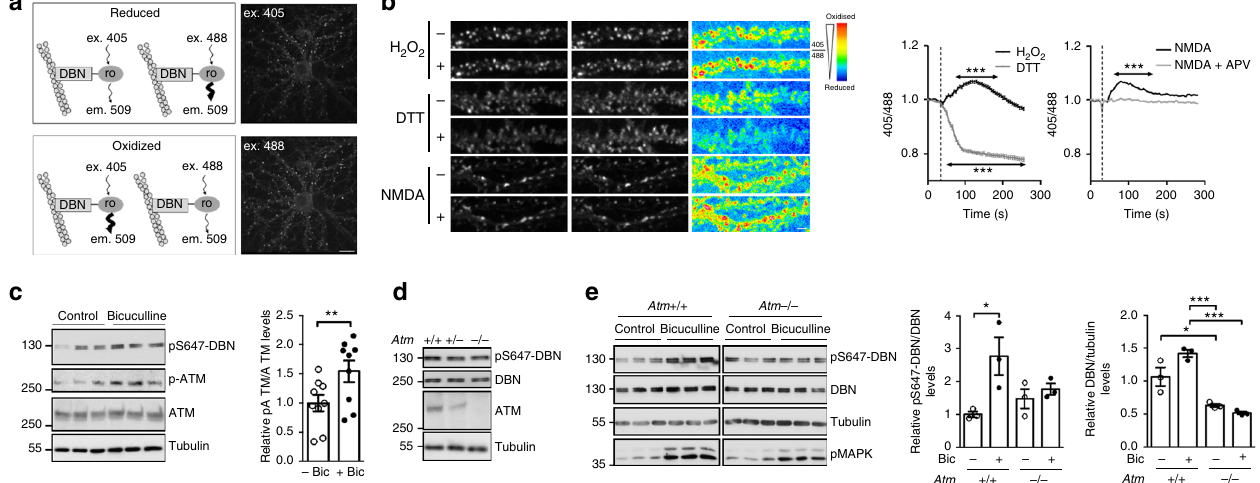
Fig. 5 ATM-dependent phosphorylation of DBN at S647 is controlled by neuronal activity. a Analysis of the redox environment in dendritic spines using DBN-roGFP. Left: excitation/emission properties of DBN-roGFP. roGFP has two excitation peaks at ~405 and ~488 nm and a single emission peak at 509 nm. Reduced conditions result in a higher excitation at ~488 nm and a lower excitation at ~405 nm. The reverse occurs under oxidized conditions. Right: DIV21 hippocampal neurons expressing DBN-roGFP excited at 405 nm (upper neuron) or 488 nm (lower neuron) and detected at 509 nm. Scale bar 15 µ m. b Neuronal activity changes the redox environment in the proximity of DBN. Left: Representative dendrites of DIV21 hippocampal neurons expressing DBN- roGFP excited at 405 nm ( fi rst column), 488 nm (second column) or false-coloured 405/488 ratios (third column) before ( − ) and after ( + ) treatment. Scale bar 3 µ m. Right: mean 405/488 ratio traces ± SEM. H 2 O 2 , DTT or NMDA were applied as indicated by a dotted vertical line. H 2 O 2 : n = 125 spines from 13 neurons of three independent experiments; DTT: n = 71 spines from 10 neurons of three biologically independent experiments; NMDA: n = 94 spines from 11 neurons of three biologically independent experiments; NMDA + APV: n = 88 spines from 11 neurons of three biologically independent experiments. One-way ANOVA Bonferroni test. *** p < 0.001 compared to T = 0. c Hippocampal neurons DIV14 were treated with 30 µ M bicuculline for 1 h before lysis. Bar graph shows the relative band density of pATM/ATM in nine independent experiments ± SEM; T test. ** p < 0.01. d Western blot analysis of Atm + / + , Atm + / − or Atm − / − hippocampal neuron (DIV 20) lysates. e Hippocampal neurons (DIV14) were treated with 30 µ M bicuculline for 1 h before cell lysis. The increase in pMAPK was used as control for bicuculline-induced network excitation. Bar graph shows the relative band density of pS647-DBN/DBN (left) and DBN/tubulin (right) in three biologically independent samples ± SEM; One-way ANOVA Bonferroni test. * p